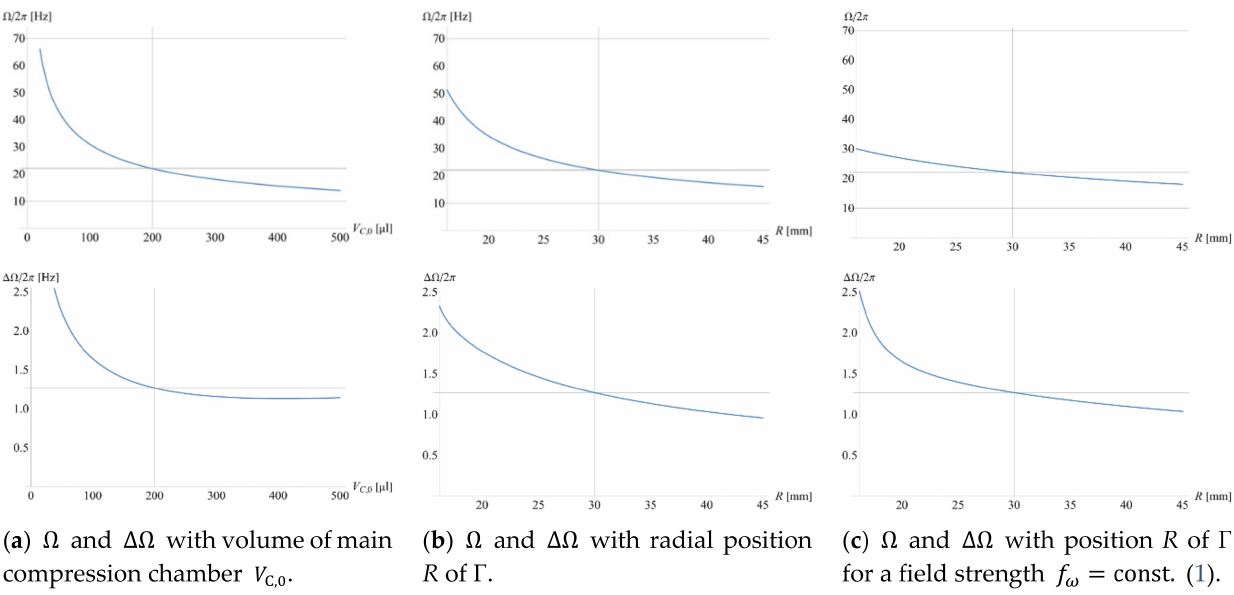
Figure 2. Variation of retention rate Ω (11) and its standard deviation ∆Ω (20) with ( a ) the volume of the main, permanently gas-filled compartment of the compression chamber V C,0 and ( b ) the radial position R while leaving (the remainder of) the structure Γ unchanged. The retention rate Ω sharply increases towards shrinking compression volumes V C,0 and central placements R ; this comes at the expense of widening the tolerance ∆Ω . The gridlines represent the default volume V C,0 = 200 µ L, at a radial position R = 30 mm and retention rate Ω /2 π ≈ 22 Hz. ( c ) Ω and ∆Ω vs. R while maintaining the field strength f ω (1), originally evaluated for its default geometry Γ (Table A1), critical spin rate Ω /2 π = 30 Hz, (cid:36) = 1000 kg m − 3 and R = 3 cm, while varying the radial position R